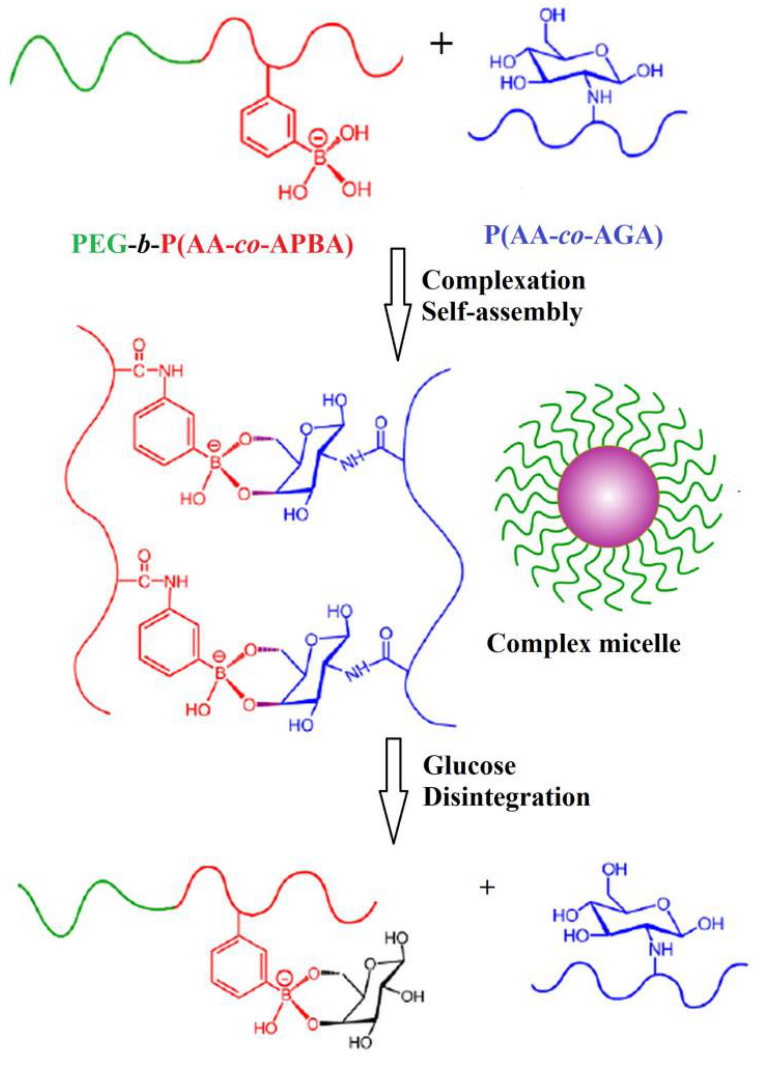
Figure 8. Schematic representation of the formation PEG- b -poly(AA- co -APBA/poly(AA- co -AGA micelles and their response in the glucose presence (Adapted with permission from [86]. Copyright © 2023, American Chemical Society).